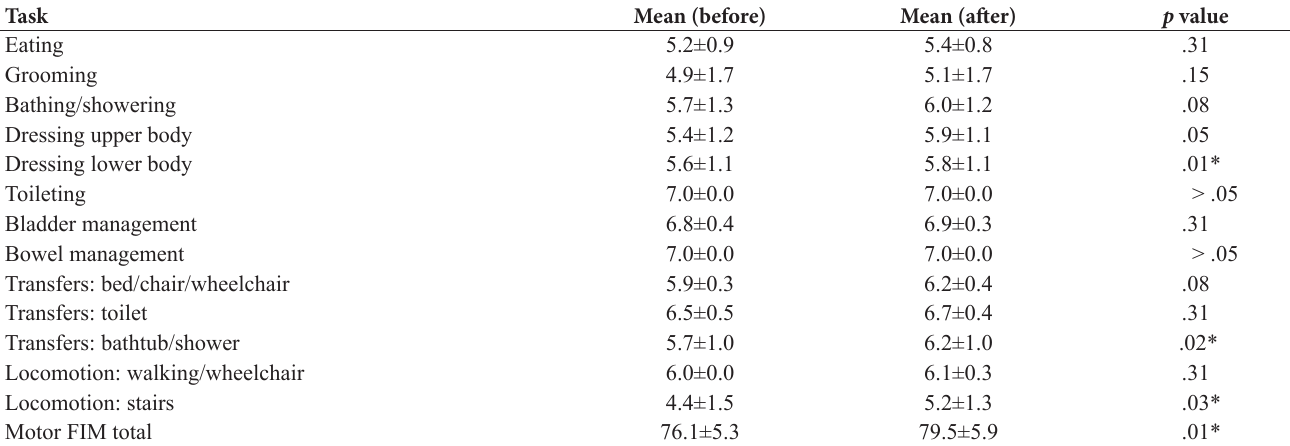
Table 1. Motor FIM Scale – Mean values before and after intervention. Task Mean (before) Mean (after) p value